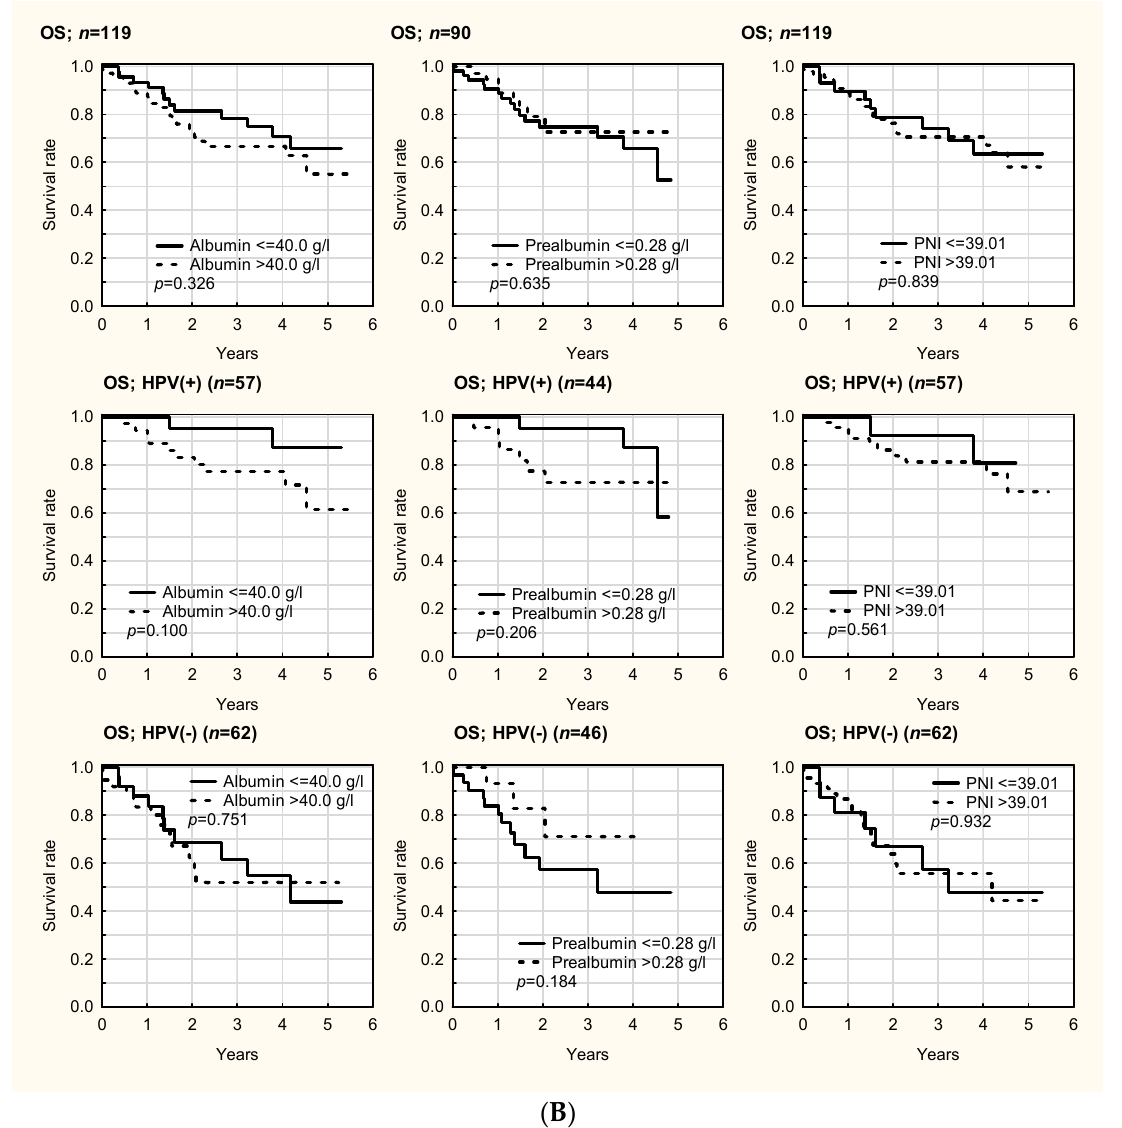
Figure 1. ( A ). Overall survival (OS) in HPV-, HPV+, and all patients according to body mass index (BMI), total lymphocyte count (TLC), hemoglobin (HB), and C-reactive protein (CRP) levels. ( B ). Overall survival (OS) in HPV-, HPV+, and all patients according to albumin and prealbumin levels and prognostic nutritional index (PNI).